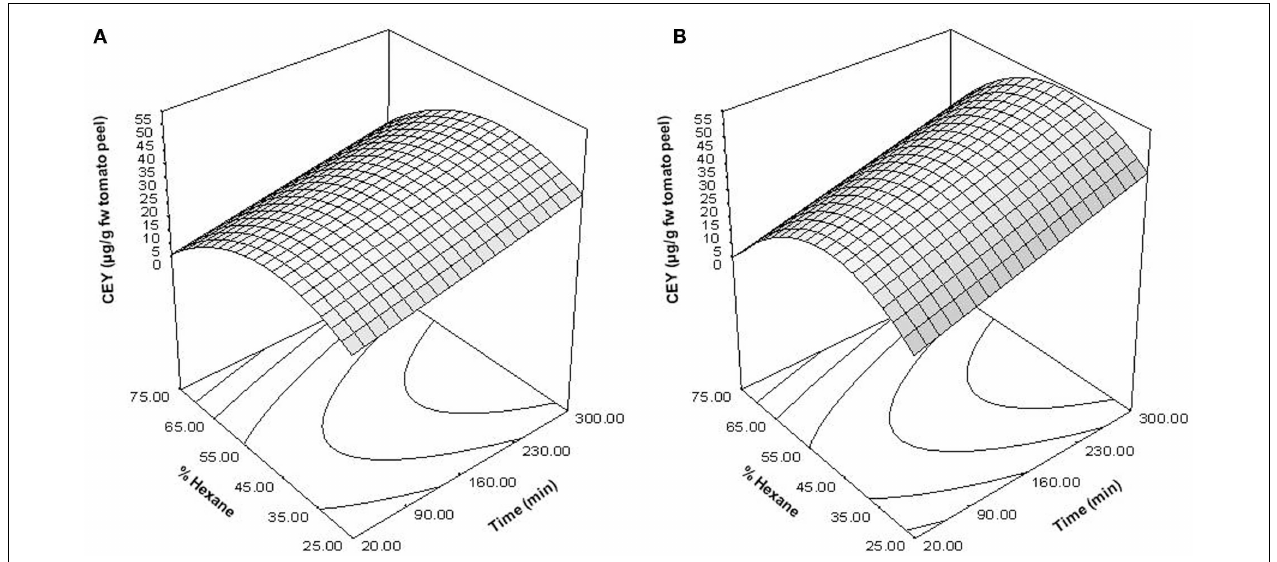
FIGURE 4 | Response surface plots showing the influence of the percentage of hexane and extraction time on the carotenoid extraction yield (CEY) expressed as microgram of carotenoids per gram of fresh weight (FW) tomato peel . Control (A) ; PEF-treated (B) .